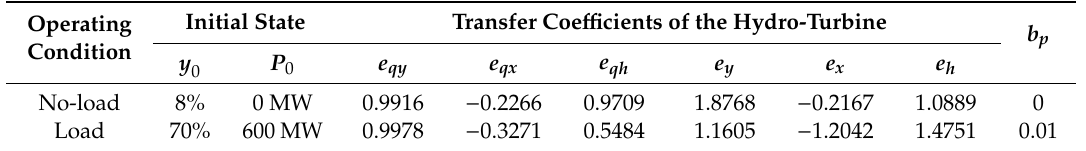
Table 1. Operating conditions of the system to be identified and the corresponding